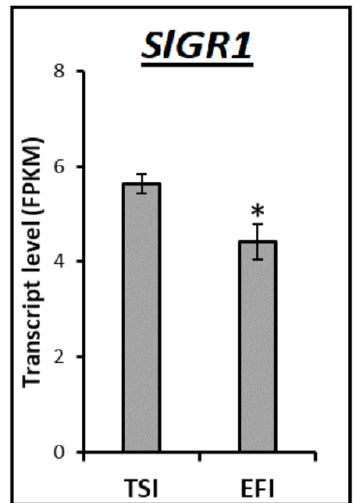
Figure 7. Effect of top sprinkle (TSI) and ebb-and-flow (EFI) irrigation on transcript profiling of CAT genes in tomato root. Vertical bars indicate means ± SE (3 biological and 3 techincal replicates). The *, ** and *** represent significance at p ≤ 0.05, p ≤ 0.01 and p ≤ 0.001, respectively, according to Student’s t -test. NS–not significant.